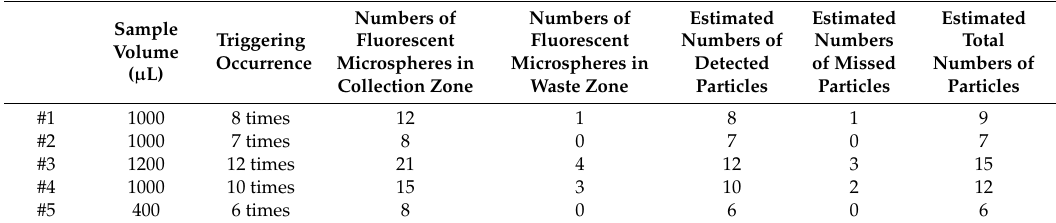
Table 1. Particle detection results using the co-planner EWOD device developed in this